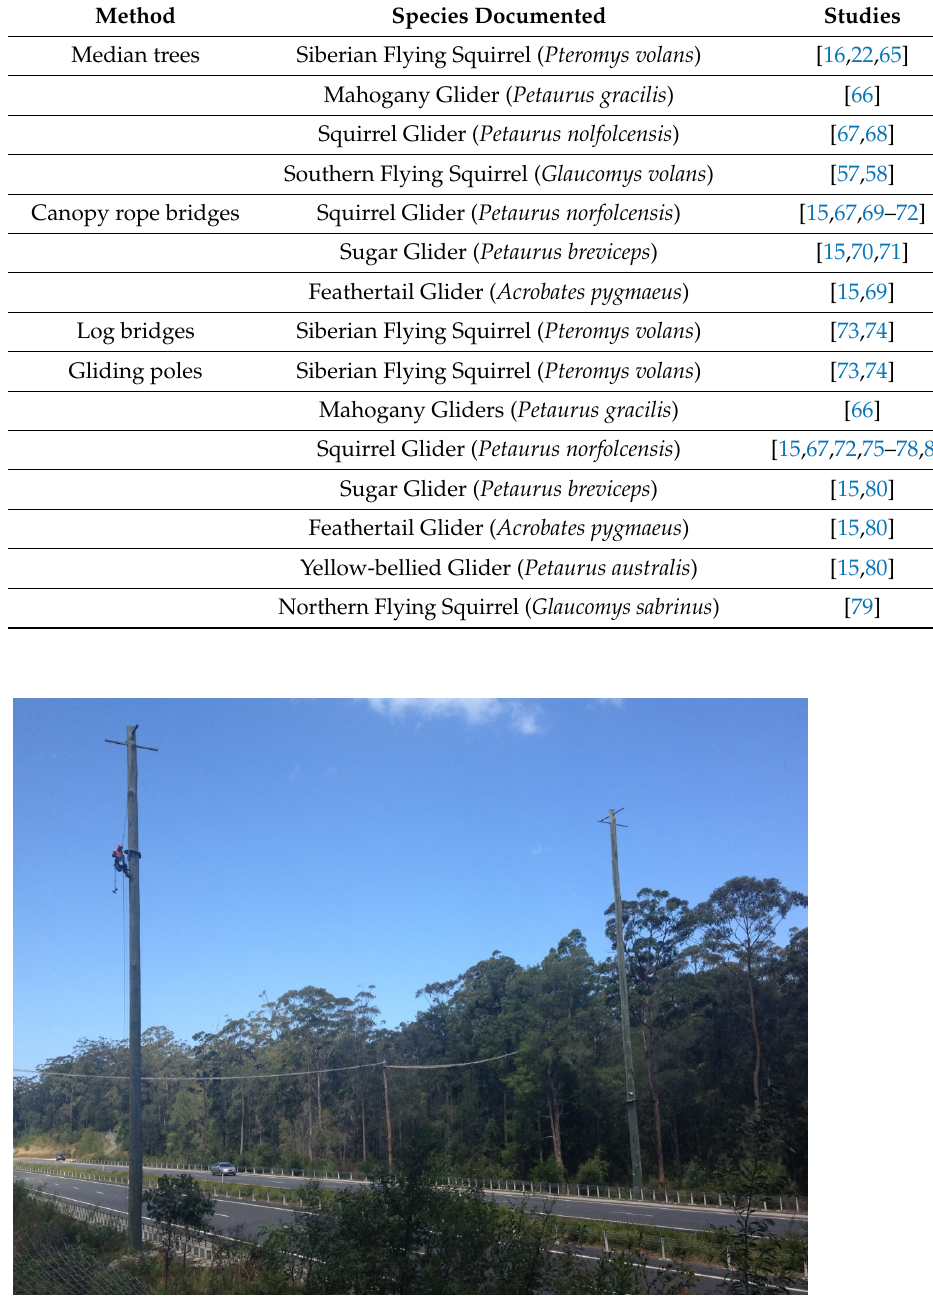
Figure 2. Example of a set of gliding poles utilized by various gliding mammals in Australia. This photograph shows poles on opposite sides of a highway, designed for glider crossing by species such as Squirrel Gliders ( Petaurus nolfolcensis ), Sugar Gliders ( Petaurus breviceps ), Feathertail Gliders ( Acrobates pygmaeus ), and Yellow-Bellied Gliders ( Petaurus australis ). Photo captured and provided by Dr. Ross Goldingay at Southern Cross University.